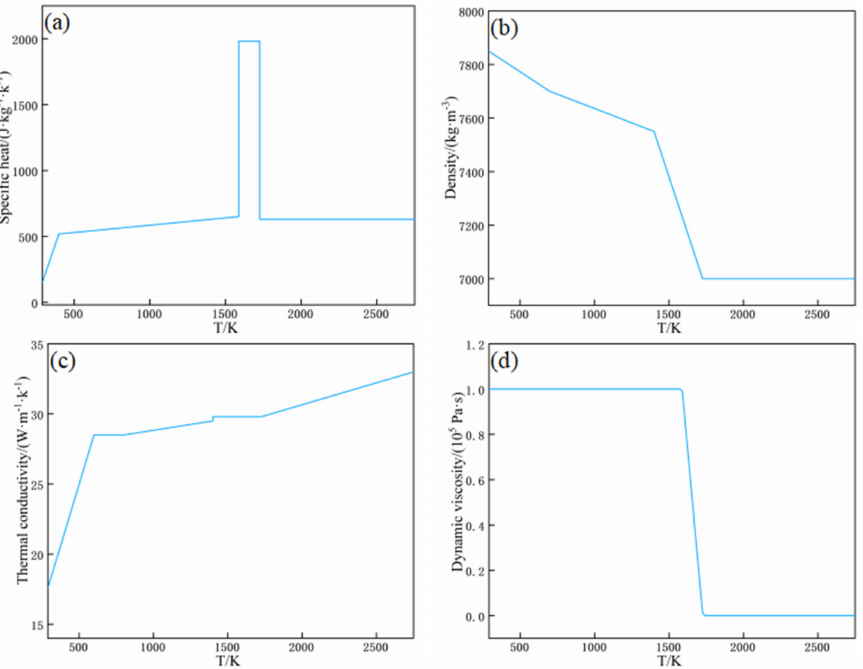
Figure 9. Thermophysical parameters of the materials: ( a ) specific heat capacity; ( b ) density; ( c ) thermal conductivity; ( d ) dynamic